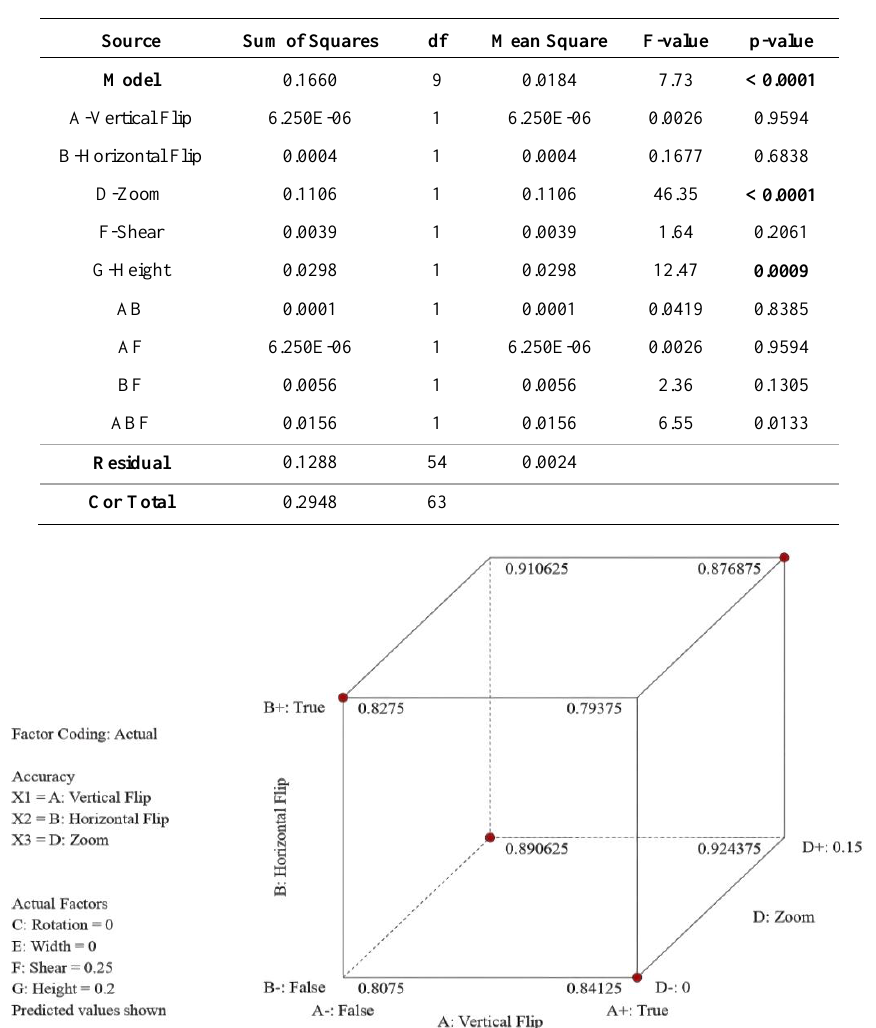
Table 5. ANOVA Results for Dataset 1